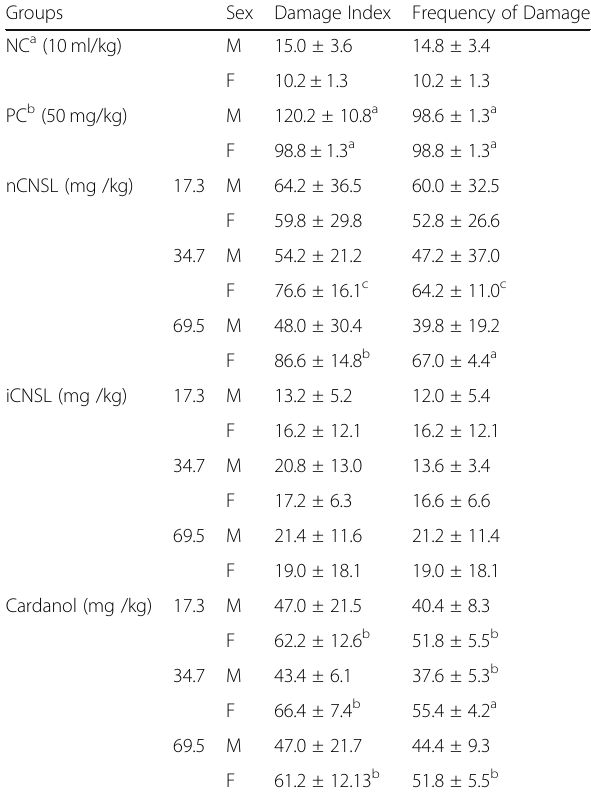
Table 1 Overview of damage and damage rate (mean ± SD) in bone marrow cells of mice after 24 h of oral (p.o.) administration of nCNSL, iCNSL and